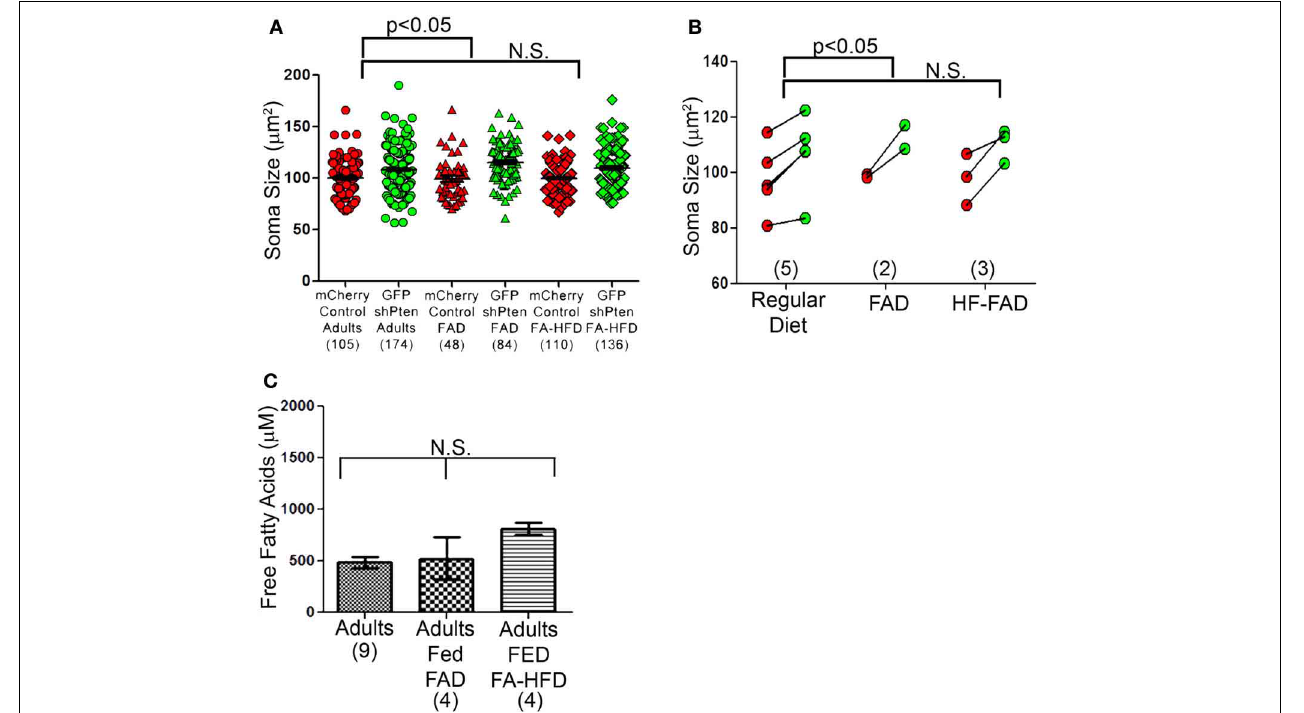
from 2 animals. mCherry control FA-HFD = 99 . 8 ± 1 . 40 µ m 2 , GFP shPten FA- HFD = 109 . 8 ± 1 . 63 µ m 2 , p < 0 . 01, n = 110 and 136 neurons from 3 animals). For the FA-HFD, there was no evidence for an increase in soma size further than Pten knockdown alone, but there was a significant increase in the FAD (regular chow vs. FAD, p < 0 . 05) (C) Levels of free fatty acids (FFA) were measured in the serum of adults fed normal chow, the FAD, and the FA-HFD. None of the diet manipulations increased the circulating FFA levels of the adults (Adult fed regular chow = 486 . 8 ± 53 . 94 µ M FFA, Adult fed FAD = 525 . 6 ± 206 . 6 µ M FFA, Adult fed FA- HFD = 811 . 6 ± 56 . 23 µ M FFA, p > 0 . 05, one-way ANOVA, n = 9, 4, and 4 animals,